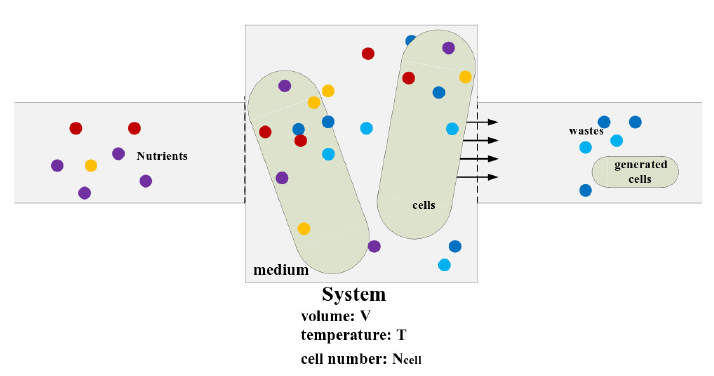
Figure A1. The schematic diagram of the system. The container is full of culture medium. The volume of system is V , the temperature of system is T , and the number of cells in the system is N cell . We add fresh culture medium into the system and drain newly generated cells and metabolic wastes off the system to ensure the system is at a steady state. That is, the concentrations of components in the system are constant at steady states. The time average of every physiological variable is also constant, such as the average size and dry mass of cells in the